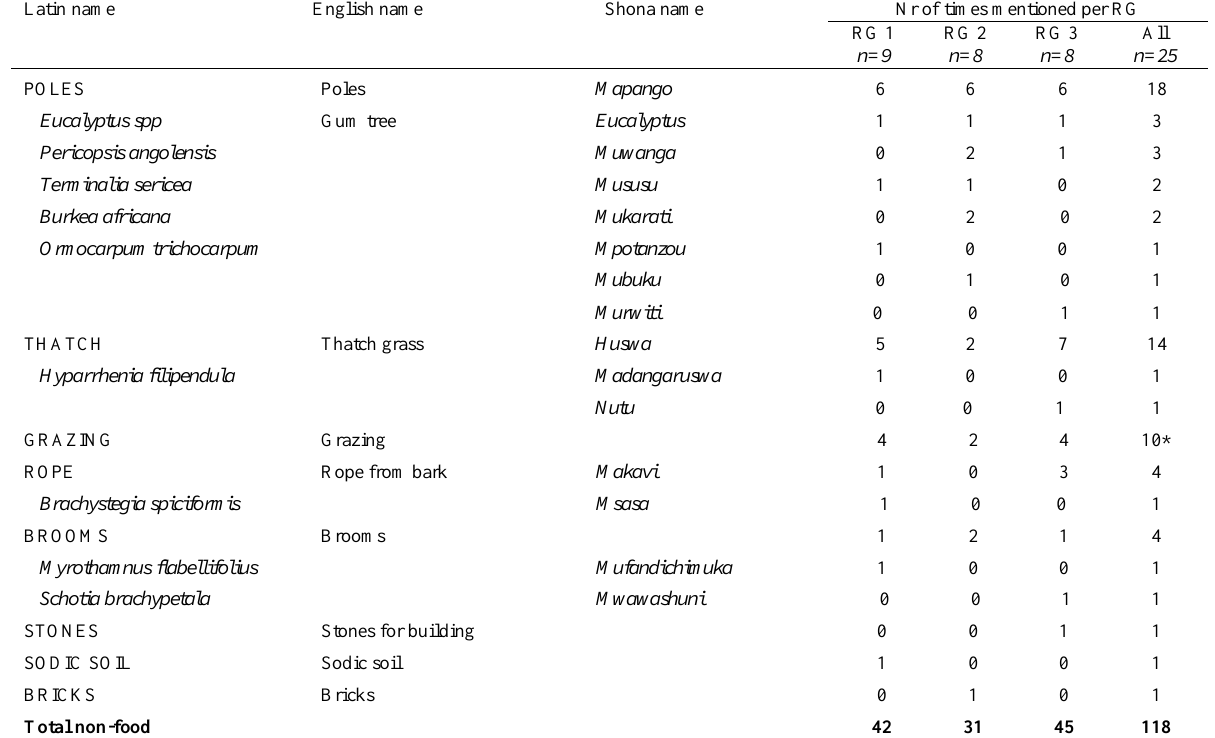
Table A3.9: Non-food products, continued Latin